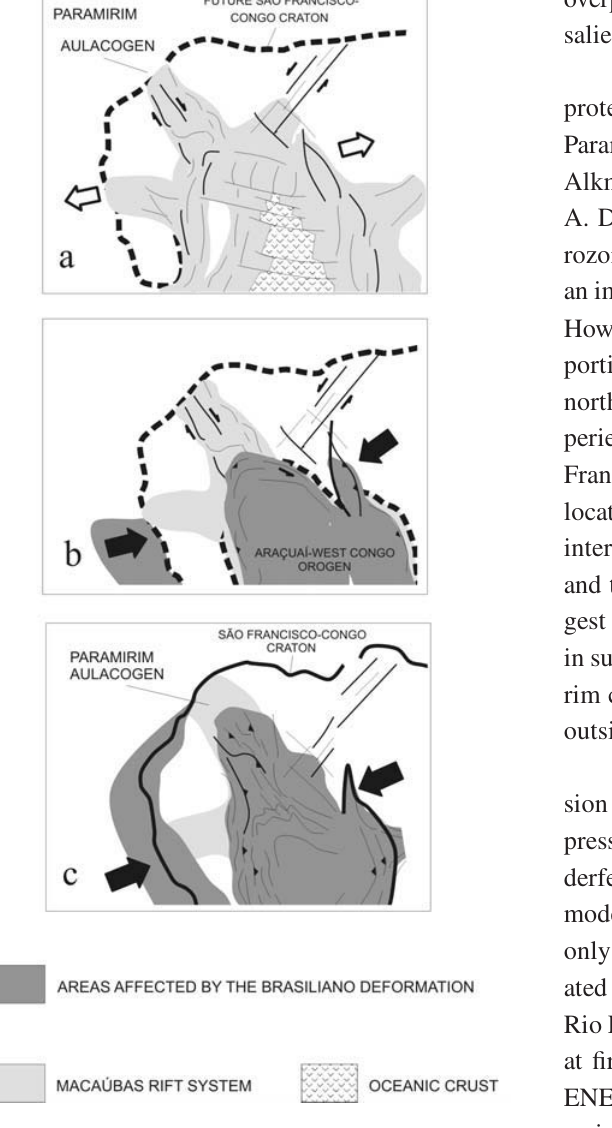
Fig. 12 – Cartoon illustrating a model for the tectonic evolution of the Paramirim aulacogen and its interaction with the Araçuaí